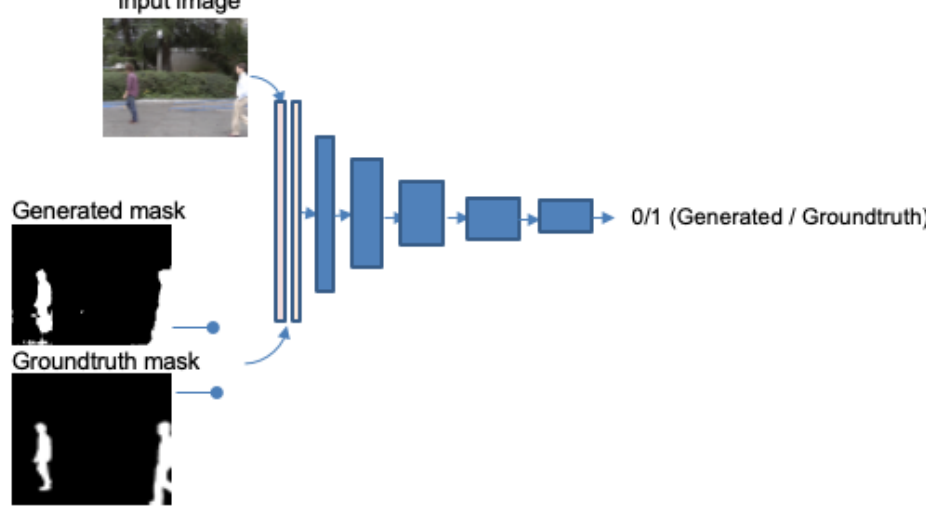
Figure 4. Scheme of the